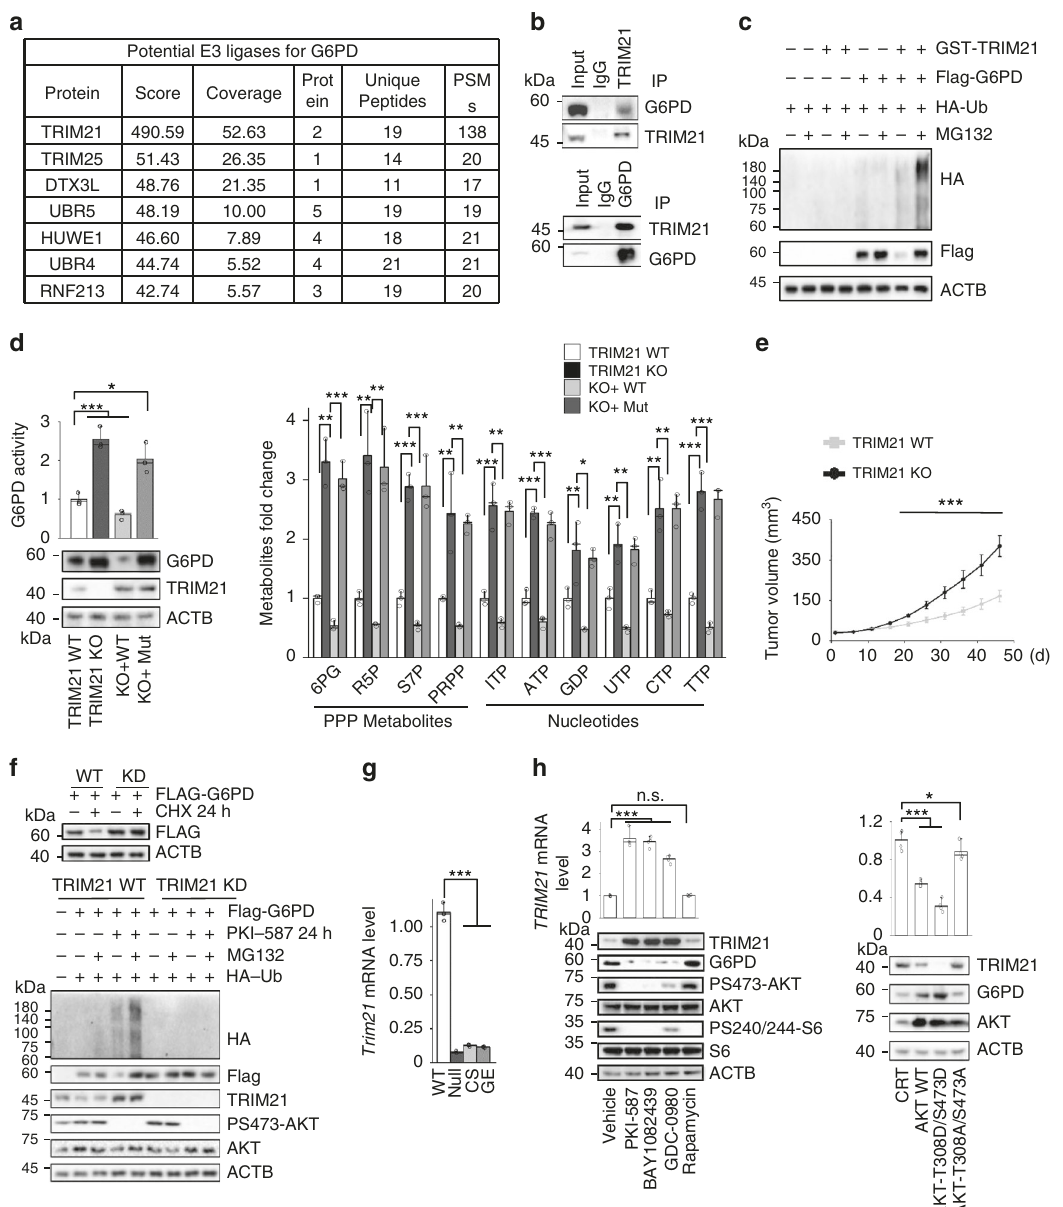
1082439 Fig. 3 TRIM21 is responsible for PI3K/AKT-regulated G6PD stability. a The potential G6PD E3 ligases identi fi ed by af fi nity MS. b TRIM21 interacts with endogenous G6PD. PC3 cell lysates were reciprocally immunoprecipitated and immunoblotted with indicated antibodies. c TRIM21 controls G6PD ubiquitination. HEK293T cells were cotransfected with indicated plasmids; 24 h later, incubated with or without MG132 (5 µ M) for 16 h, Total cell lysates were immunoprecipitated with a Flag antibody and immunoblotted with the indicated antibodies. d The enzymatic activity and protein levels of G6PD (left panel) and PPP metabolites and nucleotides (right panel) in the TRIM21 WT and knockout A549 cells, and knockout cells re-expressing the WT or E3 ligase-dead mutant TRIM21 plasmid. n = 6 independent xenografts. e The growth kinetics of the isogenic TRIM21 WT and knockout A549